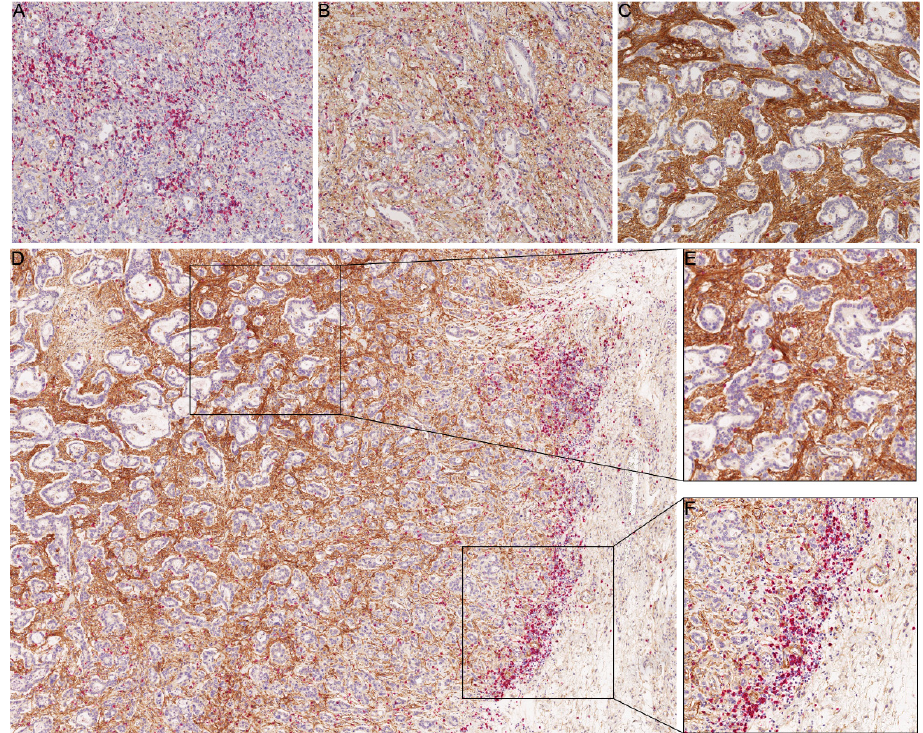
Figure 1. Immunohistochemical characterization of B7-H3 expression in gastric cancer in relation to CD8+ T cells. ( A – C ) Representative tissue sections of weak intensity ( A ), moderate intensity ( B ), and strong intensity ( C ) of B7-H3-immunostaining (brown labelling). The density of the CD8+ T cells (red labelling) in the tumour centre correlated inversely with the intensity of stromal B7-H3- immunostaining. ( D – F ) Distribution of CD8+ T cells (red) between tumour compartments in relation to B7-H3 expression (brown; D ). While the tumour centre showed strong B7-H3 immunostaining with only few CD8+ T cells ( E ), CD8+ T cells were enriched at the invasion front of the stromal compartment ( F ). Anti-B7-H3- and anti-CD8-double-immunostaining; haematoxylin counterstain. Original magnifications 100-fold ( A – C ), 50-fold ( D ), and 200-fold ( E , F